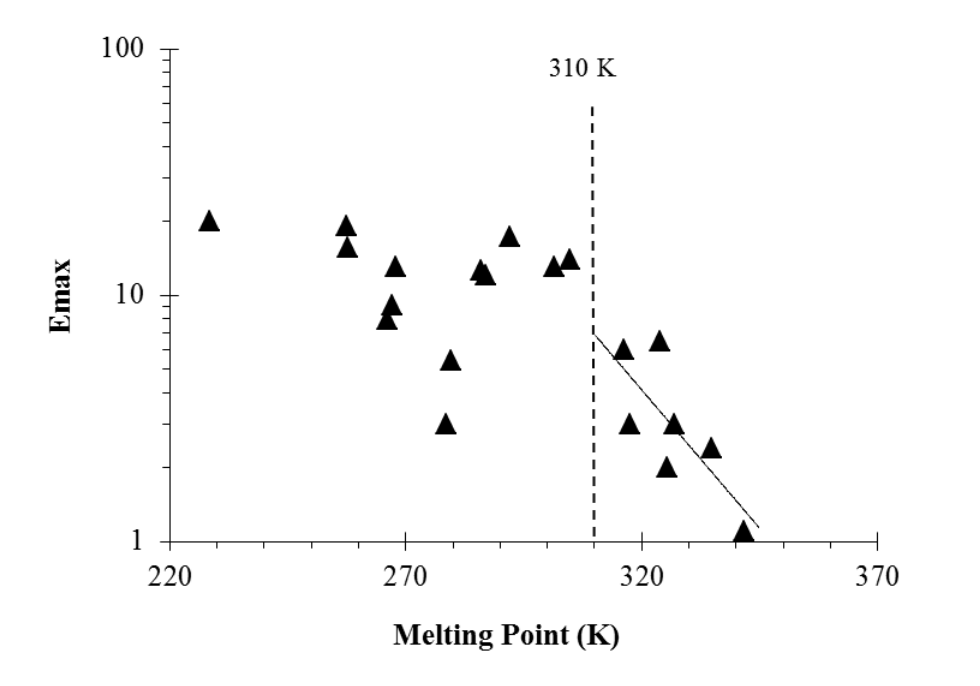
Figure 7. Maximum enhancement effects (Emax) versus the melting points of penetration enhancers. The dotted line separates the enhancers in liquid and solid states at 37 °C. The solid line is the linear regression line indicating a relationship between Emax and melting points of the solid fatty acid enhancers. The data are taken from Ibrahim et al . [40,41].